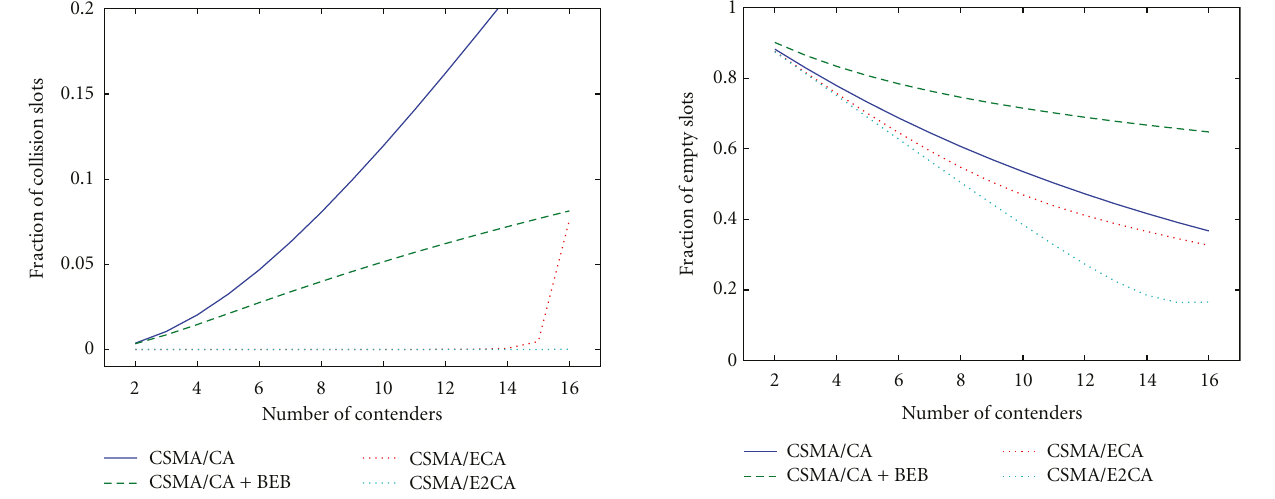
Figure 8: Fraction of empty slots for each of the three protocols under comparison for di ff erent number of contenders in a channel that drops 10% of